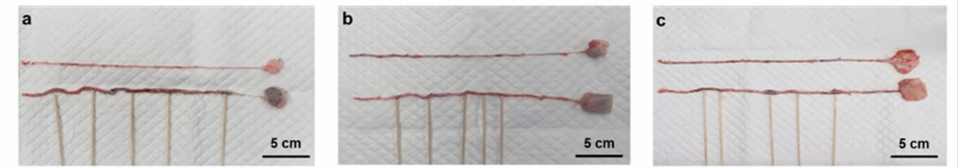
Figure 5. ( a – c ) Optical images of the EGpresto-injected epigastric veins (below) and non-treated veins (above) exposed from three mini-pigs after 14 d of the procedure. The injected sites for the treated veins are indicated by wooden